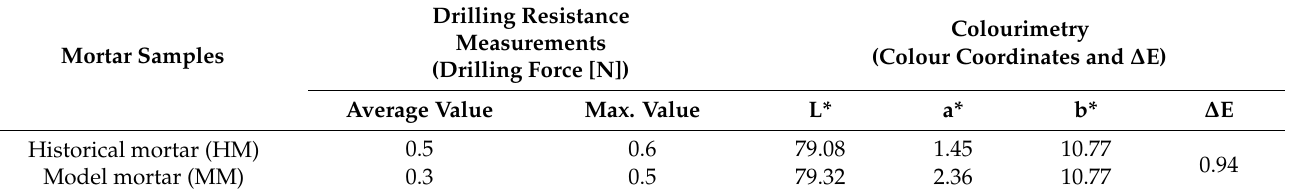
Table 4. Mechanical properties and spectrophotometry results